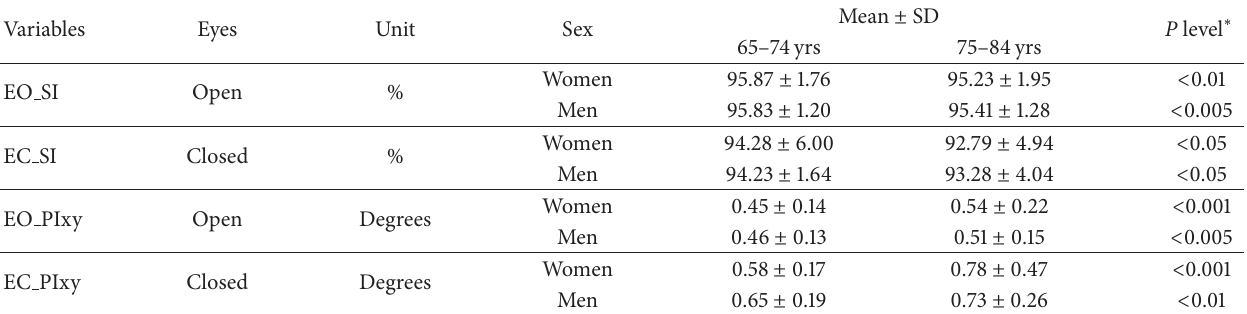
Table 4: The results of the Double Stance Test (DT). Each variable in the first column is identified by a compound name which includes the eye condition and the name of the basic